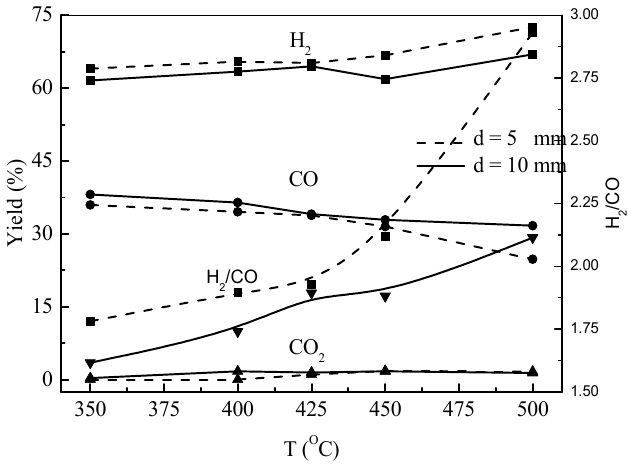
Figure 2. The influence of temperature on the syngas composition (plate position: 15 mm, superficial gas velocity: 2.95 mm /